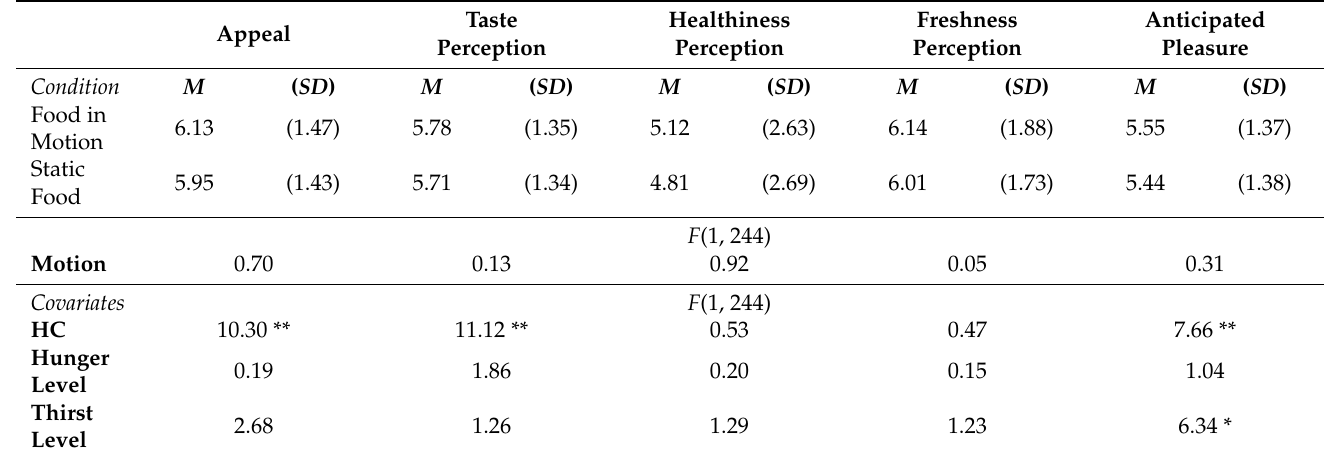
Table 5. Descriptives and multilevel results from the main effects in Study